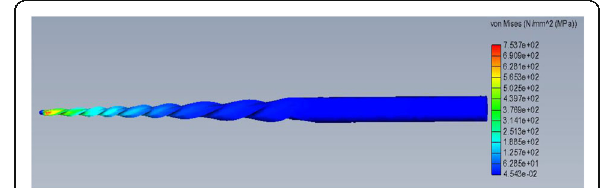
Fig. 8 Stress distribution during torsion test of